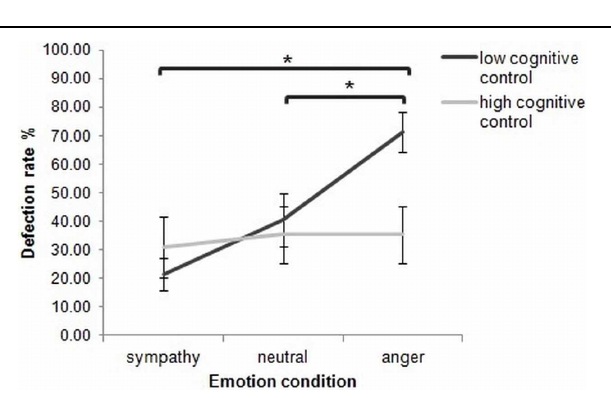
FIGURE 5 | In the Prisoner’s Dilemma, the effect of emotion on mean percentage defection rate depended upon cognitive control group. The asterisks highlight significant paired comparisons after Bonferroni correction ( p ≤ 0 . 017). Error bars represent ± 1